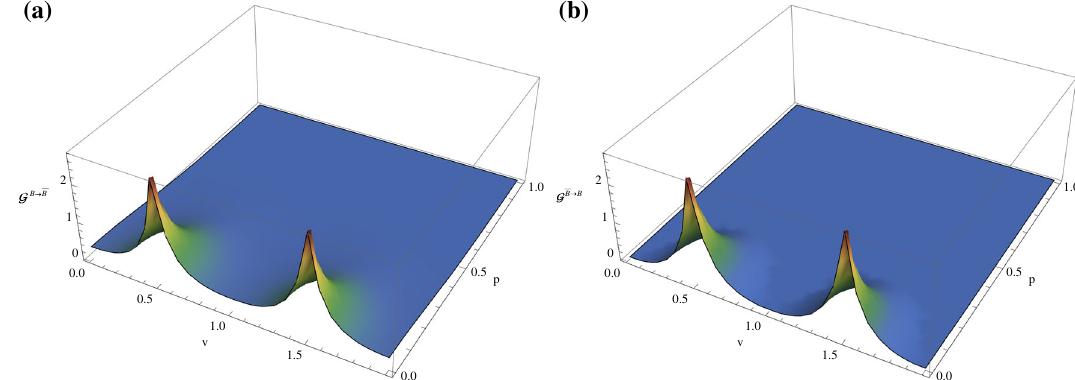
¯ B ¯ B → B (left) and G (right) as functions of the curvature parameter p and mass parameter ν of the